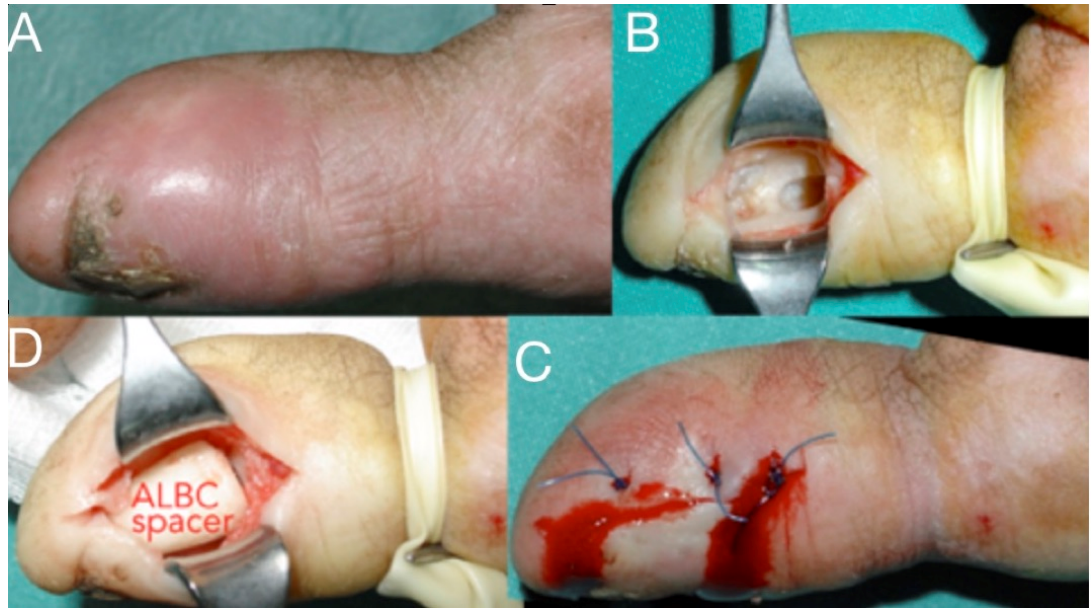
Figure 8. Infection at the distal phalanx of the thumb after a crash injury left for secondary healing ( A ), Thorough debridement from a lateral approach ( B ), antibiotic-loaded bone cement spacer for three weeks and wound closure ( C , D ). The spacer will be replaced with bone graft at a second stage.